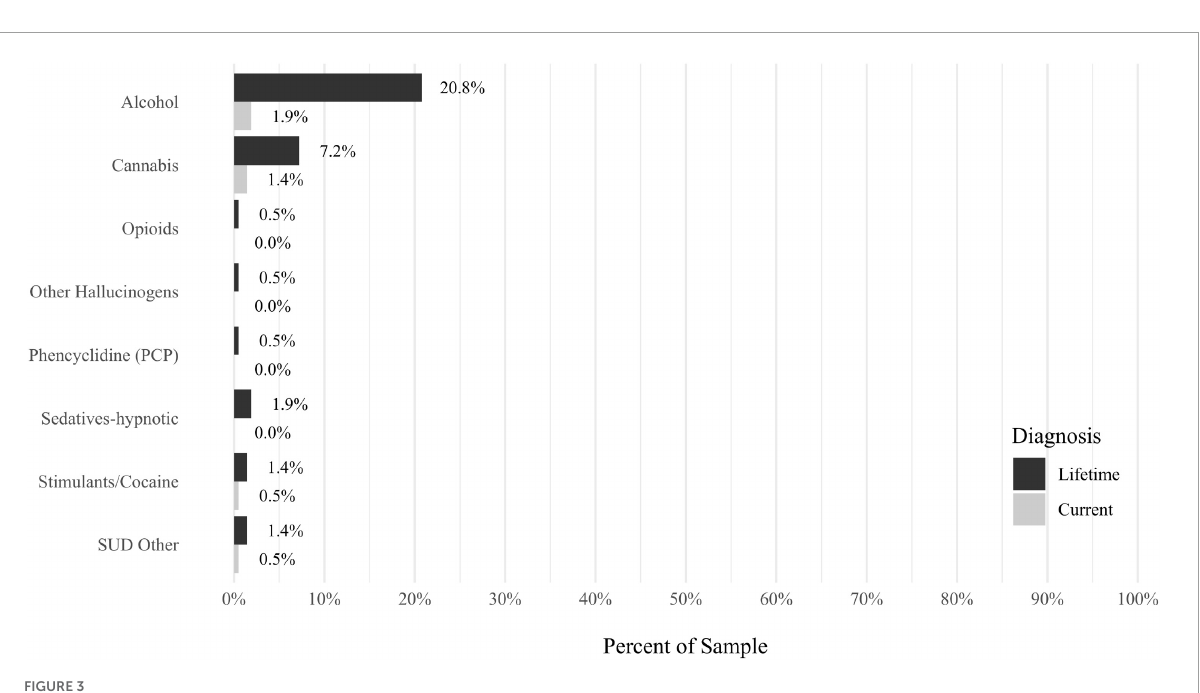
FIGURE3 Rates of psychiatric disorders: substance